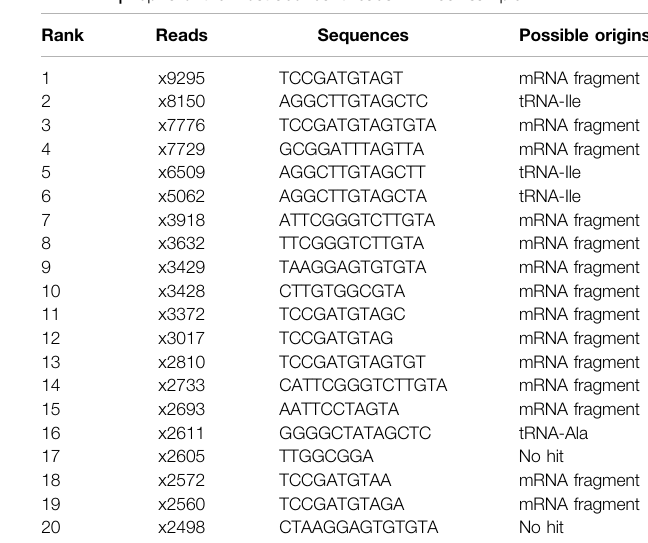
TABLE 1 | Top20 of the most abundant reads in E. coli